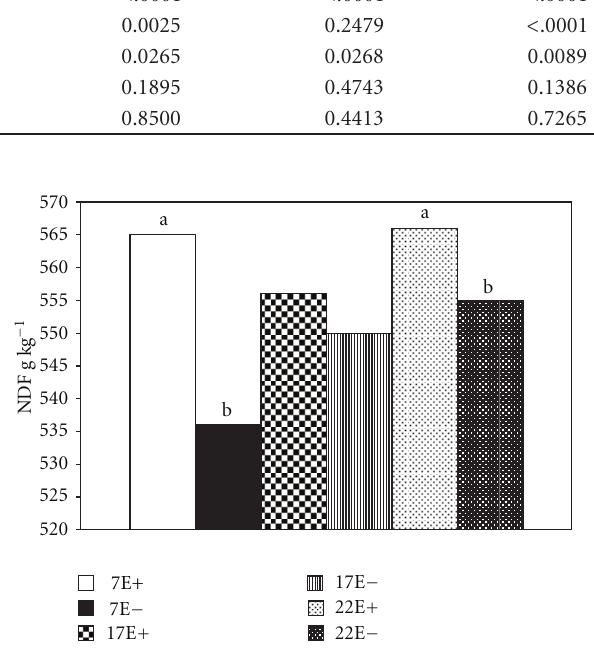
Figure 1: Plant × endophyte e ff ect on g kg − 1 dry matter mean NDF concentrationsfromthe field. Withinplant, bars with di ff erent letters are significantly di ff erent at P = .